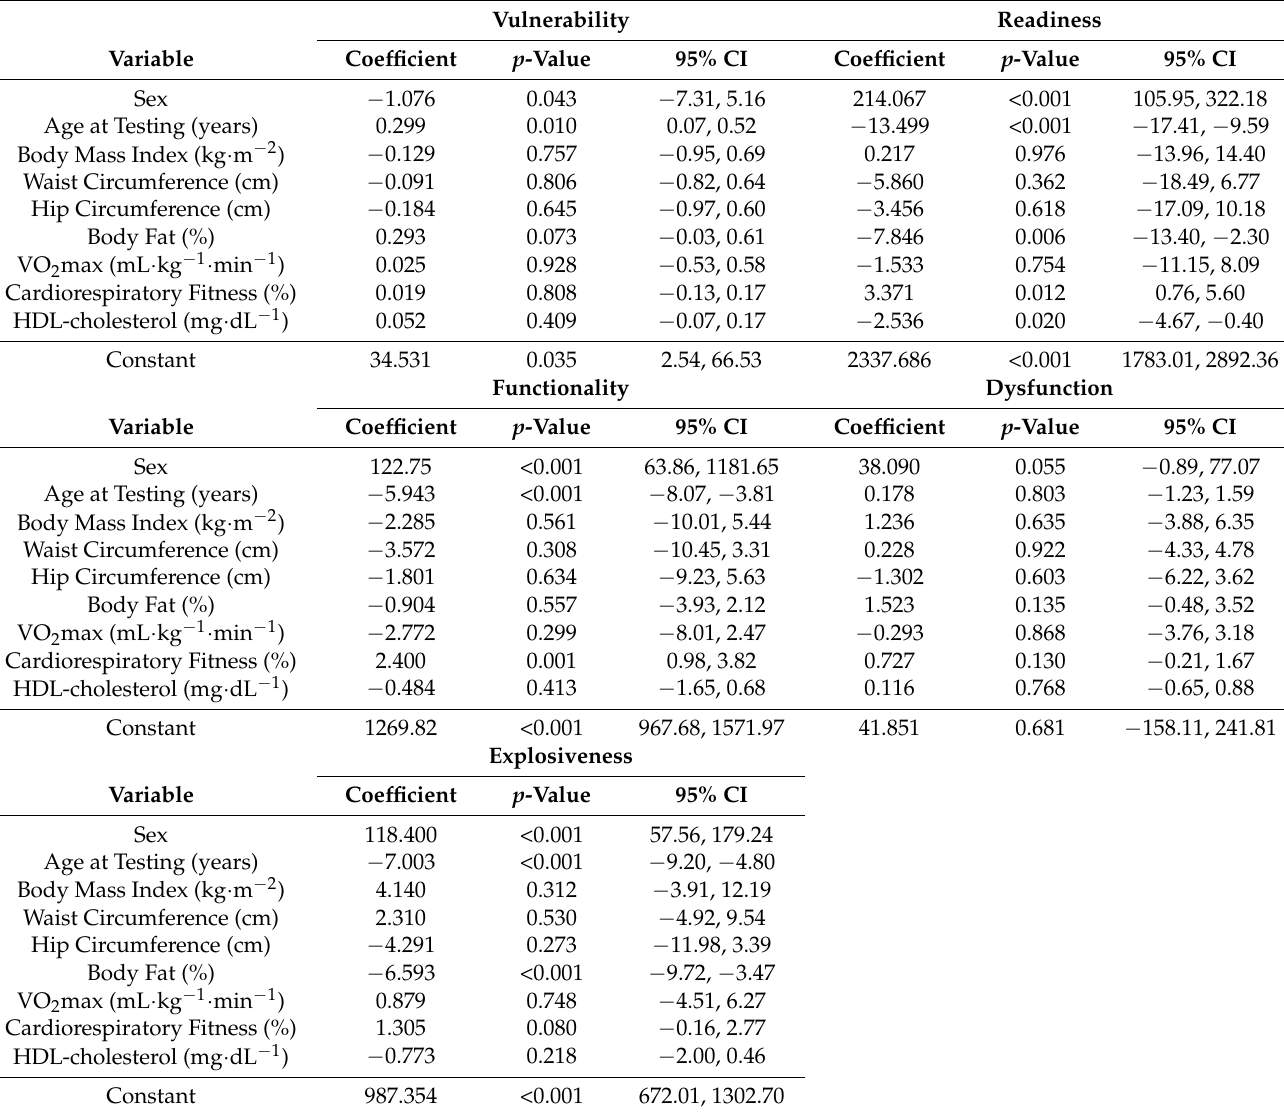
Table 4. Unstandardized beta coefficients for the linear regression model used for the prediction of five functional movement screening scores (i.e., readiness, explosiveness, functionality, dysfunction, and vulnerability) based on health-related fitness parameters examined in the present study ( p -value = represents statistically significant contribution of each predictor variable; sex = 0 for female, 1 for male; 95% CI = 95% confidence